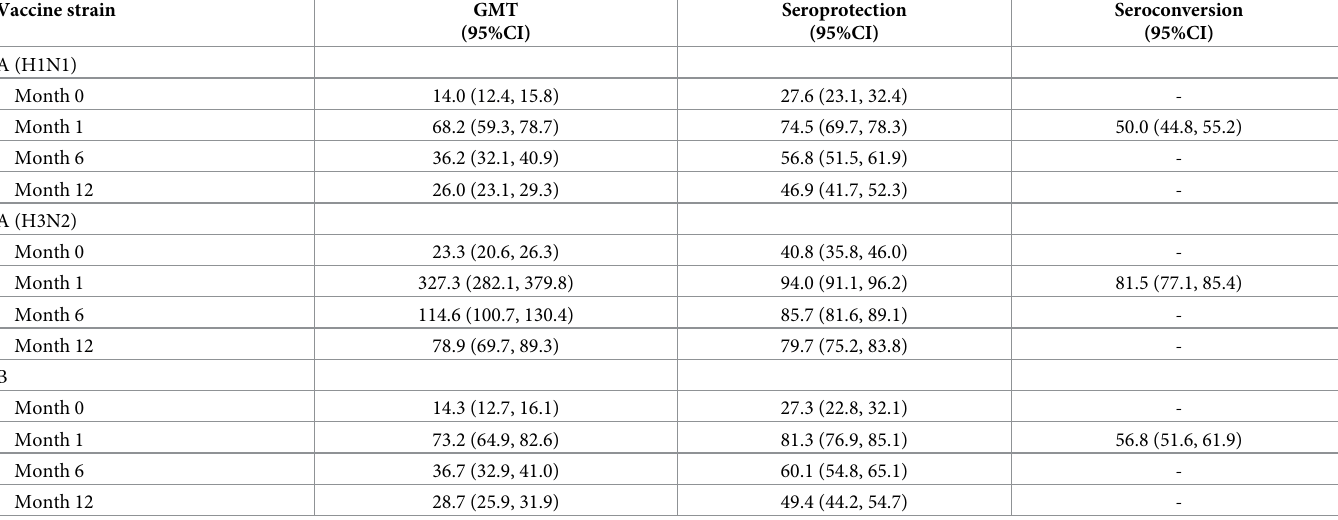
Table 2. Overall GMT (geometric mean titer) seroprotection and seroconversion overtime by influenza vaccine strains. Vaccine